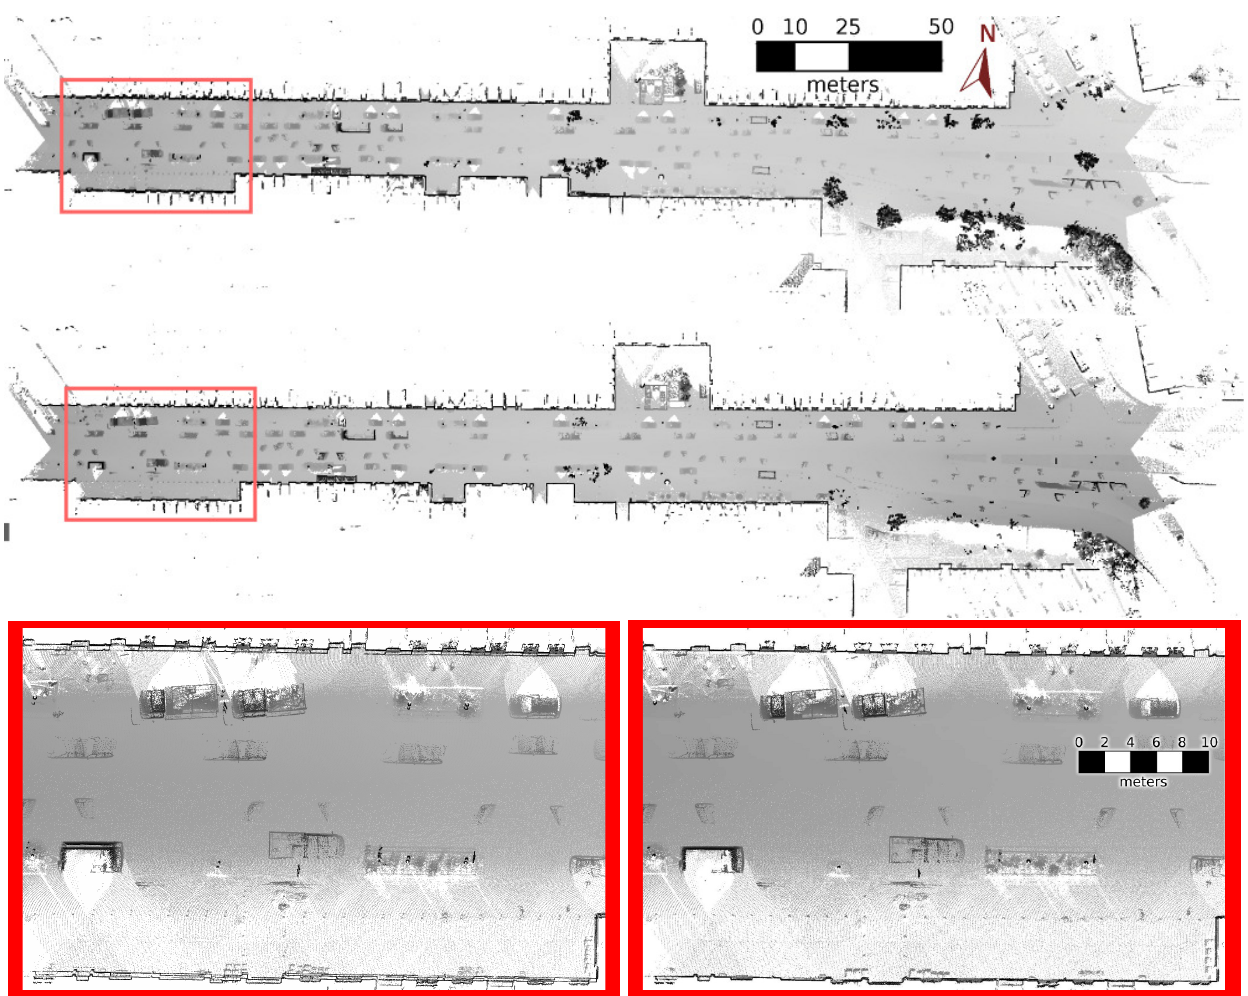
Figure 16. The larger Dortmund 2 dataset acquired by TopScan GmbH. The state-of-the art original dataset is shown in the top and the bottom left. The dataset after optimization is shown in the center and bottom